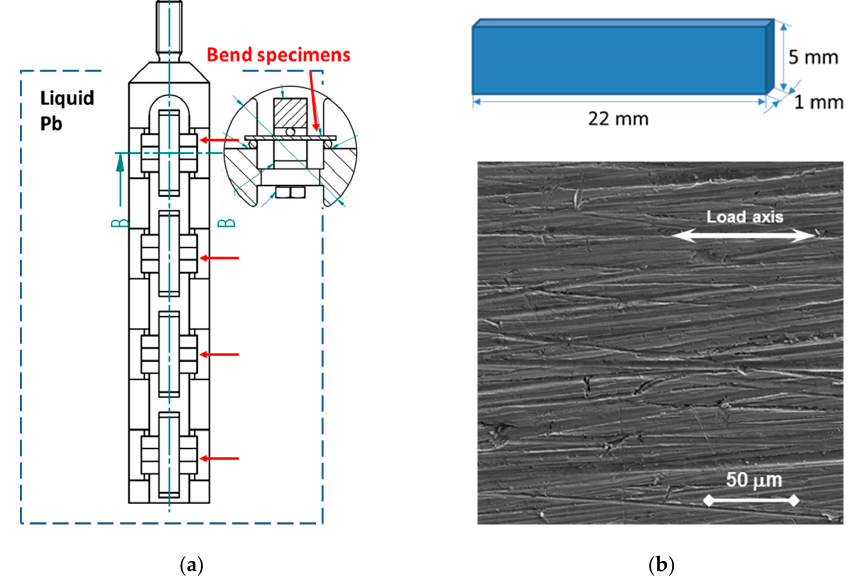
Figure 2. Bend specimen testing: ( a ) Scheme of 4 × 3 specimen holder; red arrows mark sets of three parallel specimens, each set is pre-loaded to a different stress level. ( b ) Schematic and micrograph of the original surface of the bend specimen (Ra = 0.247 μ m) before pre-loading and exposure.